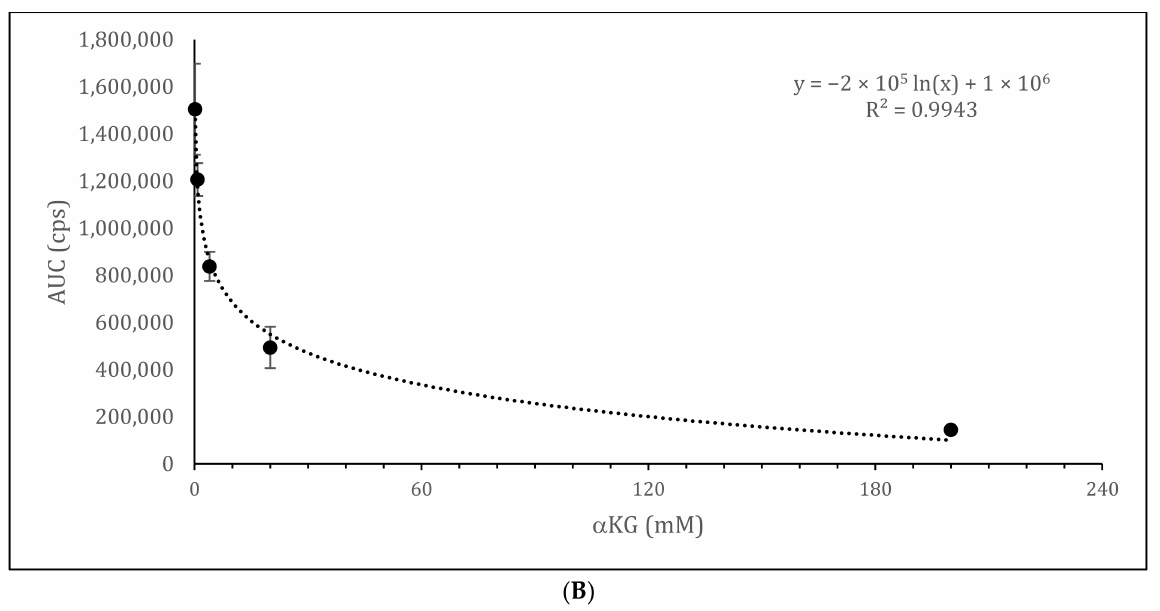
Figure 3. Standard curves of nitrated tyrosine residues on bovine serum albumin (BSA) using sandwich ELISA measure- ments ( A ; n = 5) and ( B ) calculated nitro-tyrosine residues on BSA protein in the absence or presence of 0–24 mM α KG. The relation and its regression term between nitrated tyrosine protein and 0 (control), 3, 6, 12, and 24 mM α KG concentrations ( n = 5) were calculated. * p < 0.01: significant compared to the control; ** p < 0.001: significant compared to the